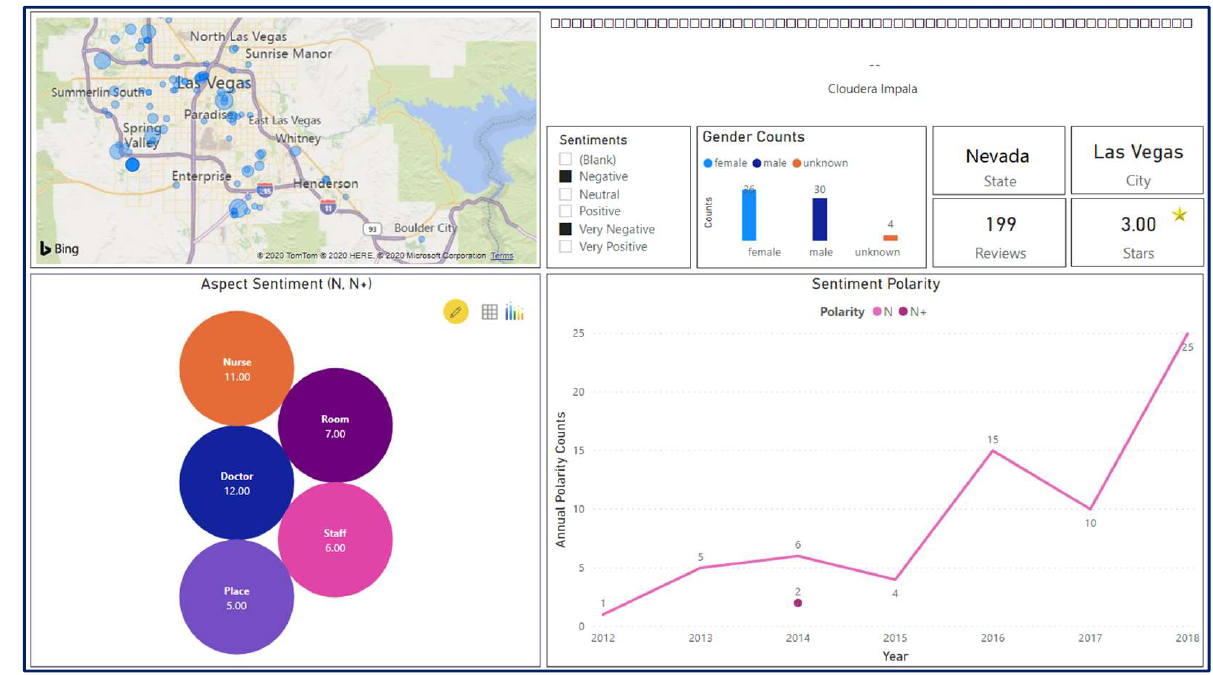
Figure 11. Analysis presentation (positive sentiment aspects).